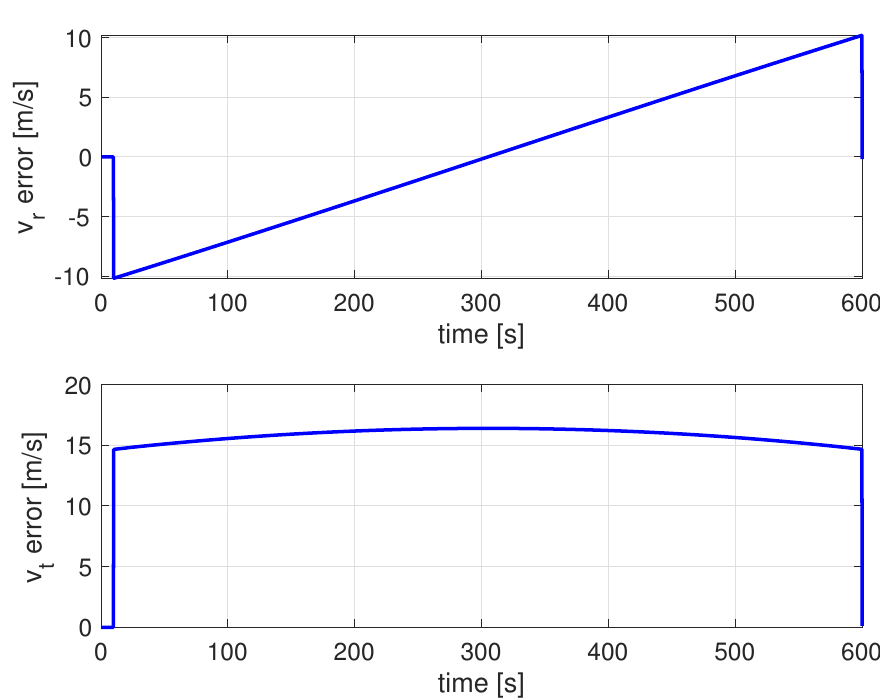
Figure 3. Velocity errors in the radial and transversal directions.